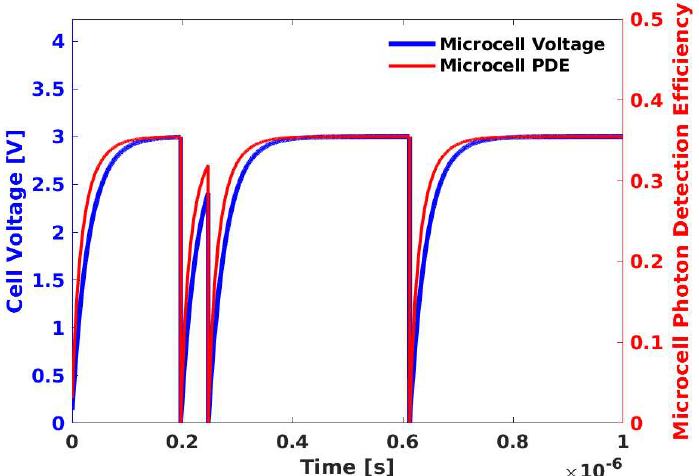
Figure 9. A representative microsecond of a simulation of one microcell showing the recovery of the over-voltage and PDE. In addition, these results show an example, at approximately 0.25 µs, of a photon being detected before the microcell is fully recharged.